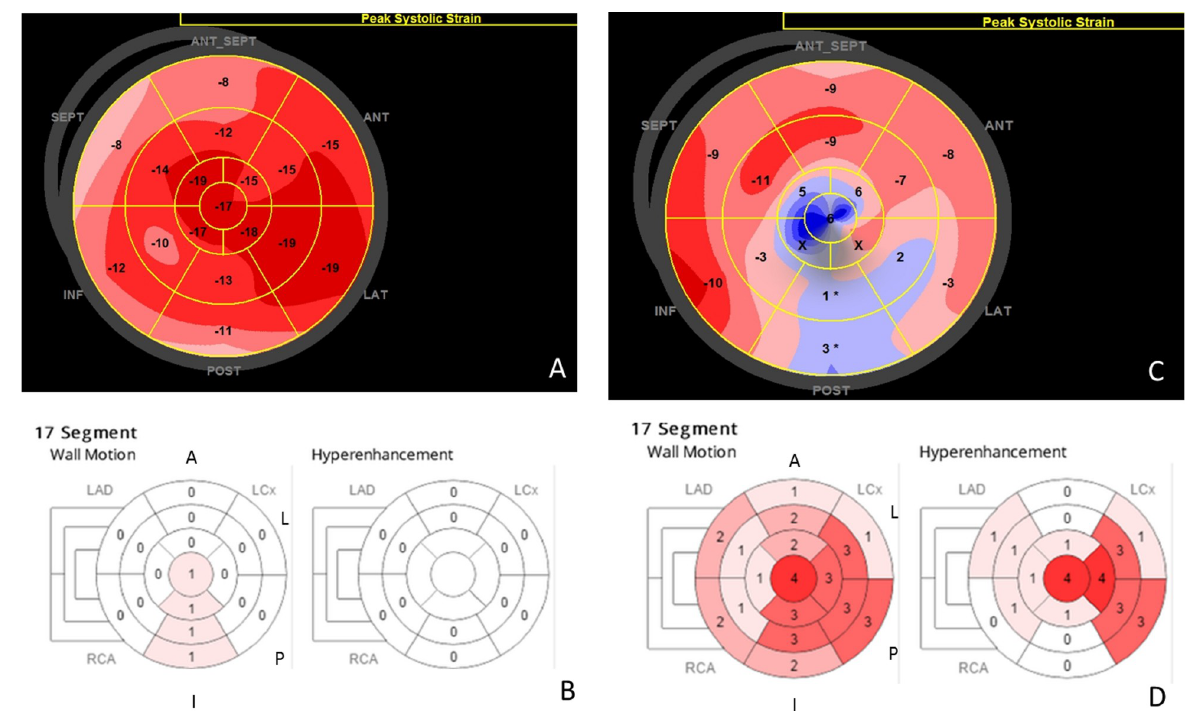
Fig 5. Illustrative examples of subjects with IFCD (panel A and B) and CCC (panels C and D). Panels A and C show RegLS in a bulls-eye representation. Inferior panels (B and D) represent wall motion values (left) and hyper-enhancement (fibrosis) at right. This IFCD subject (panel A and B) shows reduced RegLS even without myocardial fibrosis in LGE. CCC subject (C and D) shows worse RegLS values and there is a topographic correlation with fibrosis.